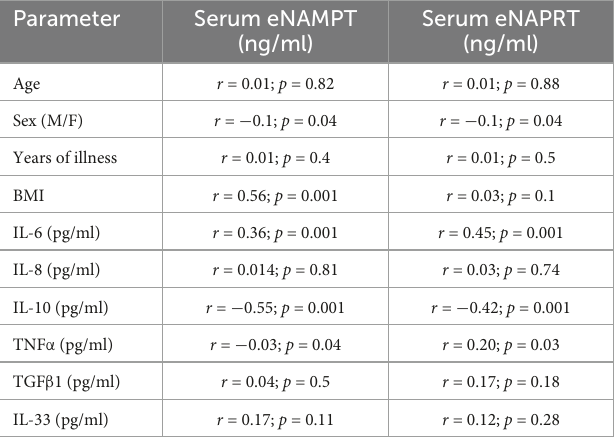
TABLE 2 Correlation between eNAMPT and eNAPRT levels with inflammatory cytokines. Parameter